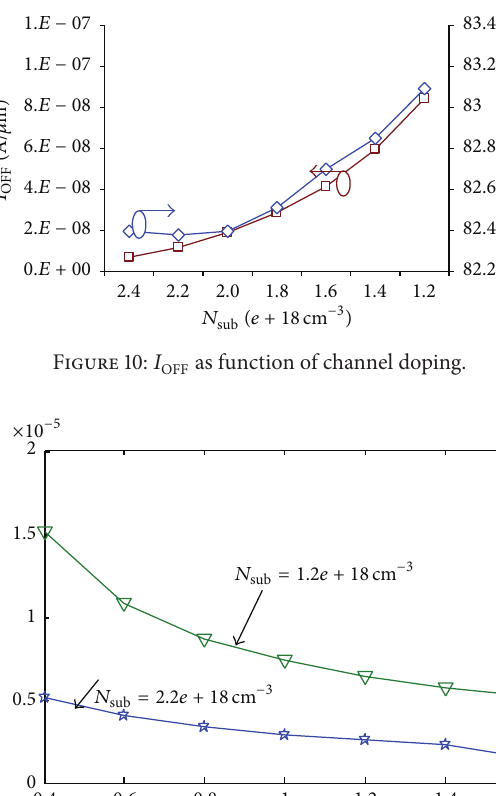
Figure 12: Subthreshold slope as a function of halo doping and channel doping.